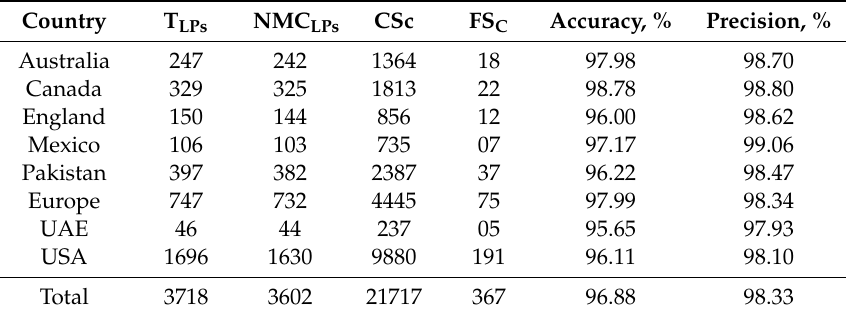
Table 3. Accuracy and precision of segmented